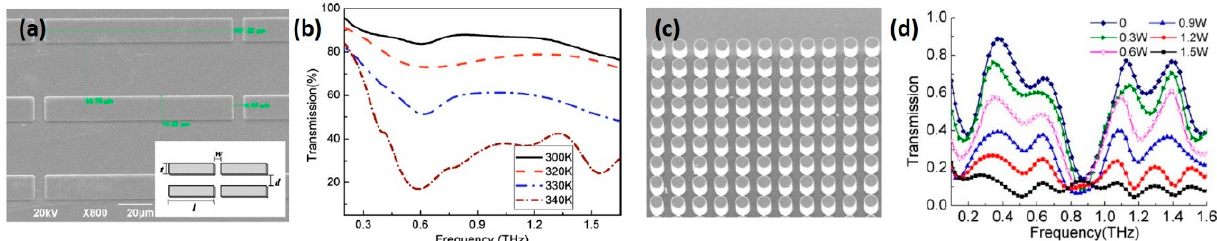
Figure 10. Tuneable metamaterials made of patterned VO 2 thick film. ( a ) SEM image of the VO 2 cut-wire array with measured dimensions of l = 107.25, w = 6.25 and t = 13.25 (all units in um). ( b ) Temperature-dependent THz transmission curves for cut-wire metamaterial. Reproduced from [139], with copyright from American Institute of Physics 2010. ( c ) SEM image of the state-conversion-plasmonics (SCP) consisting of silicon columns with VO 2 coating. ( d ) Transmission spectra of the SCP with different pump powers (532 nm CW laser) under the double 45° tilted pumping. Reproduced from [66], with permission from Optical Society of American 2013.